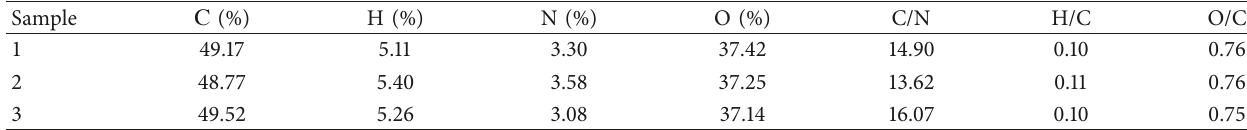
Table 2: Elemental composition of the HAs, extracted from soils. Sample